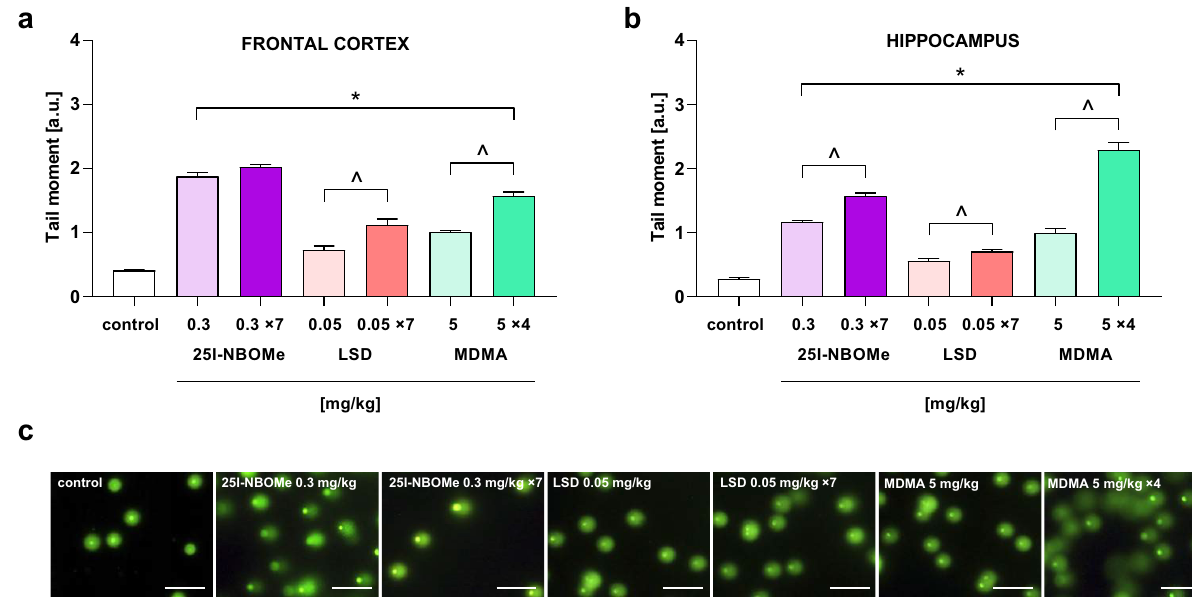
Figure 5. The effect of a single and repeated doses of 25I-NBOMe (0.3 mg/kg), LSD (0.05 mg/kg) and MDMA (5 mg/kg) on the oxidative damage of DNA in the nuclei from rat frontal cortex (that consist of the sum of FC and mPFC; a ) and hippocampus ( b ). Data are the mean ± SEM (n = 6–13 per group) and represent tail moment shown as the product of the tail length and the fraction of total DNA in the tail. ( c ) Typical microscopic images of nuclei from control, 25I-NBOMe, LSD and MDMA treated rats (scale bars = 100 μm); *p < 0.05 in comparison to control group; ^ p < 0.02 acute vs. chronic; a.u. arbitrary